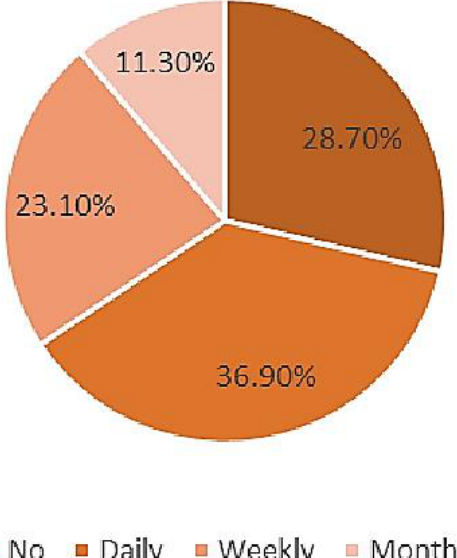
Figure 5. How often do people run into waste